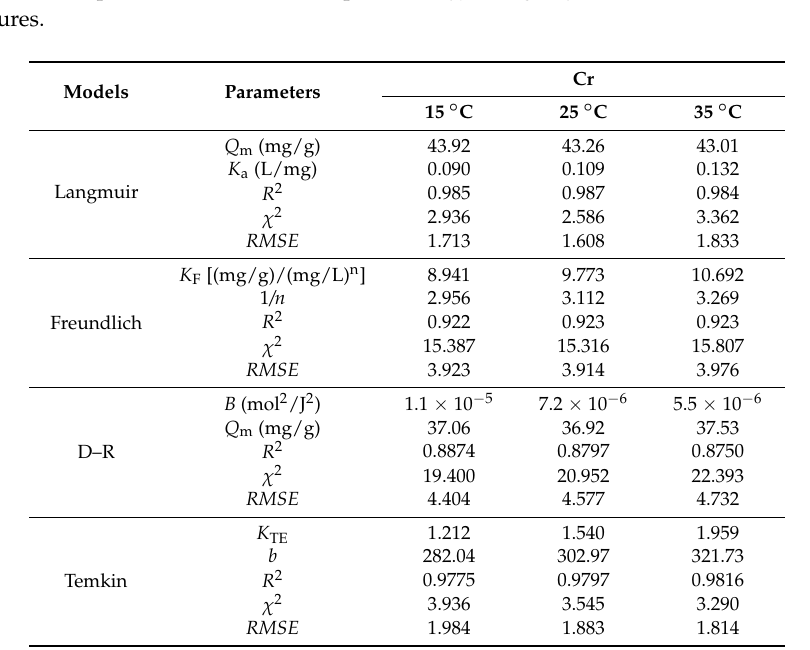
Table 2. Isotherm parameters for Cr adsorption on Typha angustifolia activated carbon at different temperatures.